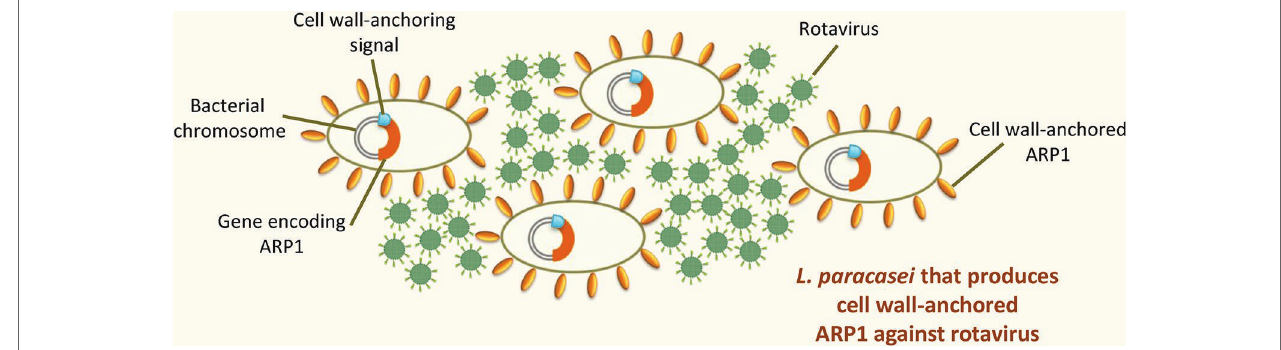
FIGURE 3 | Recombinant LAB that produce VHH against rotavirus. A recombinant Lactobacillus paracasei strain with ARP1, targeting rhesus-monkey rotavirus serotype G3, anchored to its cell wall. The expression cassette harboring the gene encoding ARP1 is fused to a cell wall-anchoring signal sequence and is stably integrated within the bacterial